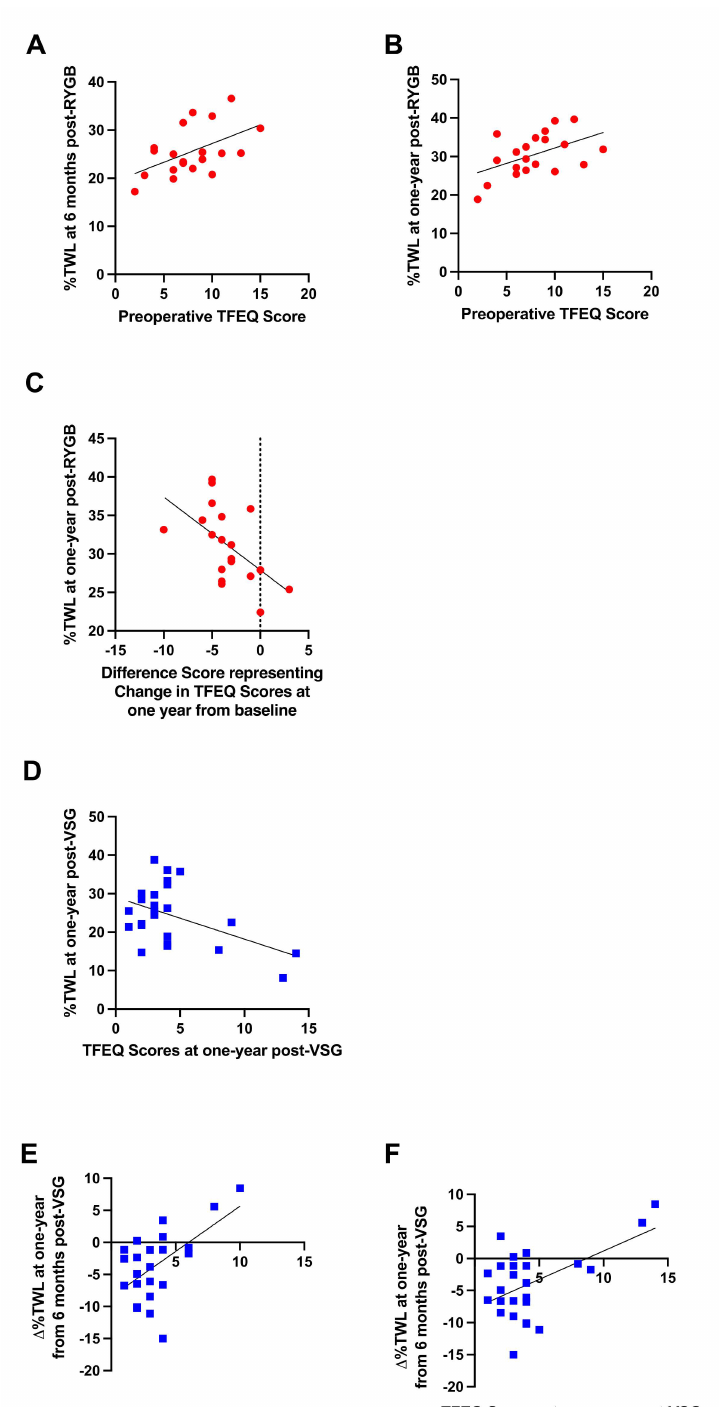
Figure 10. Significant relationships between ( A ) preoperative self-reported dietary disinhibition and %TWL at six months post-RYGB (red circles), ( B ) preoperative self-reported dietary disinhibition and %TWL at one year post-RYGB (red circles), ( C ) changes in self-reported dietary disinhibition at one year from baseline and %TWL at one year post-RYGB (red circles), ( D ) self-reported dietary disinhibition at one year from baseline and %TWL at one year post-VSG (blue squares), ( E ) self- reported dietary disinhibition at six months post-VSG and ∆ %TWL from six months to one year post-VSG (blue squares), ( F ) self-reported dietary disinhibition at one year post-VSG and ∆ %TWL from six months to one year post-VSG (blue squares). Line of best fit represents significant